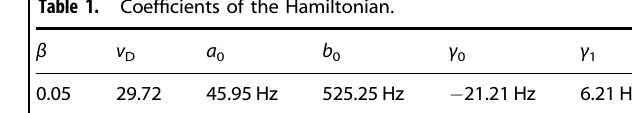
Table 1. Coef fi cients of the